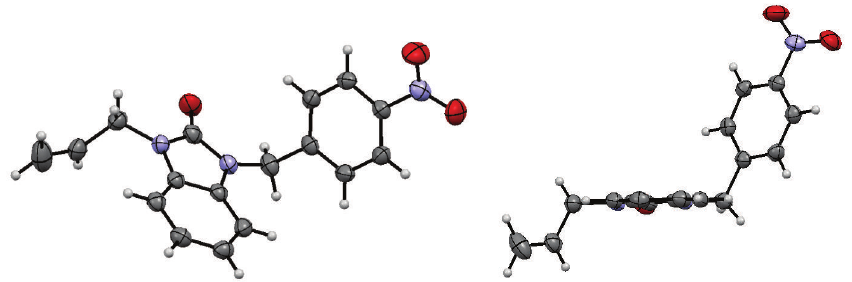
Figure 2: The unique molecule in the crystal structure of 5 (displacement ellipsoids are drawn at the 50% probability level).